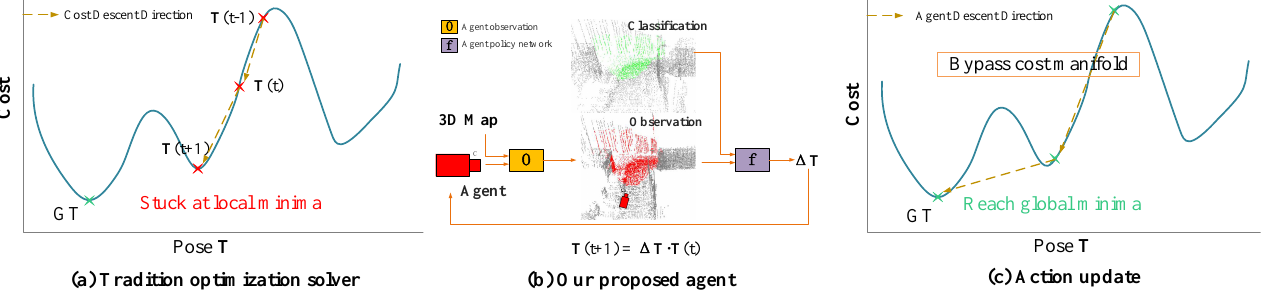
Figure 2. The difference between our approach and classic optimization approaches: ( a ) Prior structured methods rely on the cost function and are sensitive to initializations which makes them easy to become stuck in local optima. ( b , c ) Our deep agent iteratively updates the 6-DoF action based on current observation in a 3D environment, which not only eliminates local extrema but also significantly reduces the number of